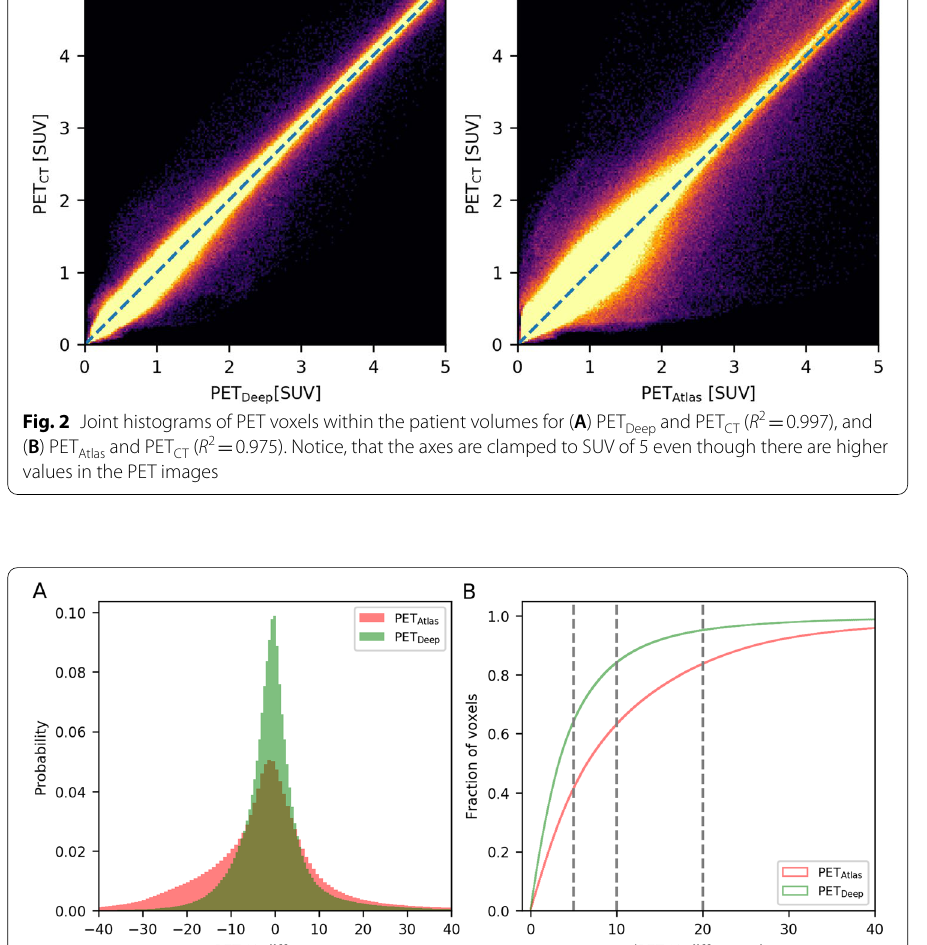
Fig. 3 ( A ) Histograms of the PET error distributions for PET Atlas and PET Deep . ( B ) Cumulative histogram of the absolute PET error for PET Atlas and PET Deep . The vertical dashed lines are located at 5%, 10%, and 20% and the corresponding amount of voxels with errors below these thresholds are 65%, 84%, and 95% for PET Deep and 42%, 64%, and 84% for PET